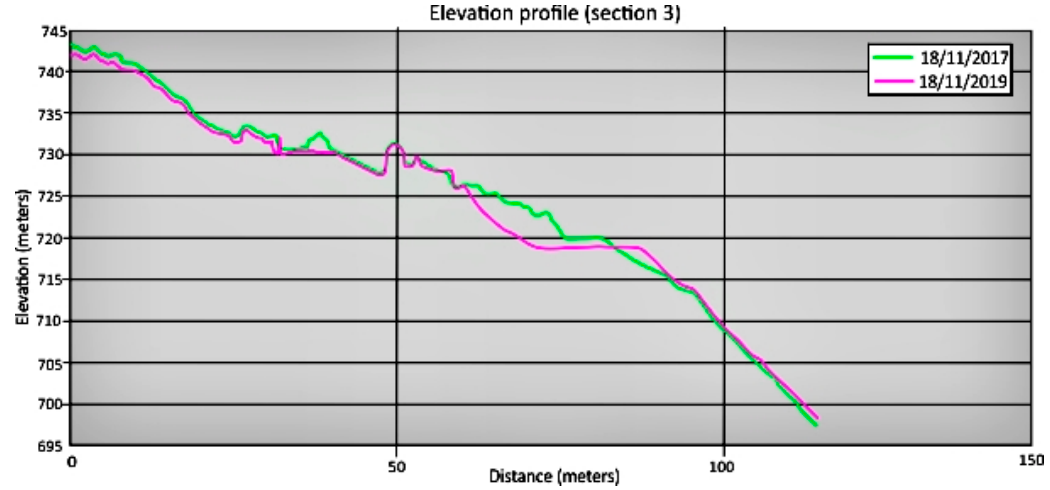
Figure 18. Elevation profiles of section 3 in Figure 11. on different dates.